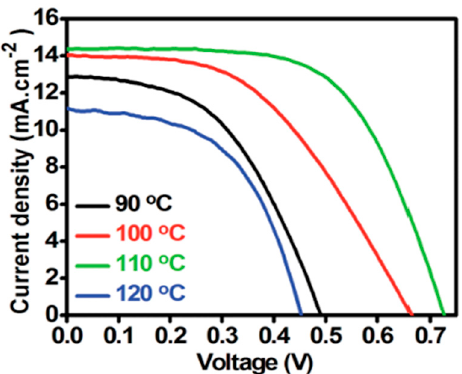
Figure 7. J-V curve of solar cells annealed at different temperatures under illumination of 100 mWcm − 2 simulated sun irradiation (1.5 AM). Reproduced with permission from Reference [69]. Royal Society of Chemistry